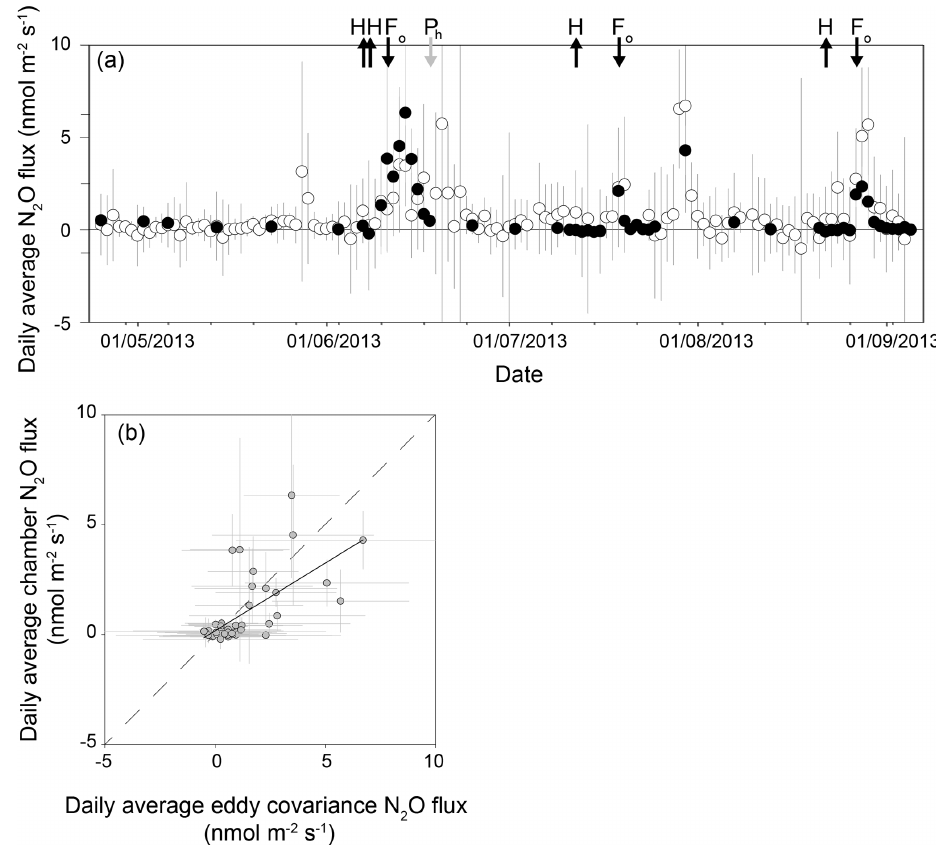
Figure 3. (a) Temporal dynamics of N 2 O fluxes measured with the eddy covariance (white circles) and manual greenhouse gas chambers (black circles measured in 2013) – grey lines indicate standard deviation. Arrows indicate management events ( H – harvest, F o – organic fertilizer application (slurry), P h – pesticide (herbicide) application). (b) A 1 : 1 comparison between chamber-based and eddy-covariance- based N 2 O fluxes in 2013. The dashed line represents the 1 : 1 line ( y = mx + c ; r 2 = 0 . 4; m = 0 . 61; c = 0 . 17; p< 0 . 0001). Sign convention: positive values denote export or release and negative values import or